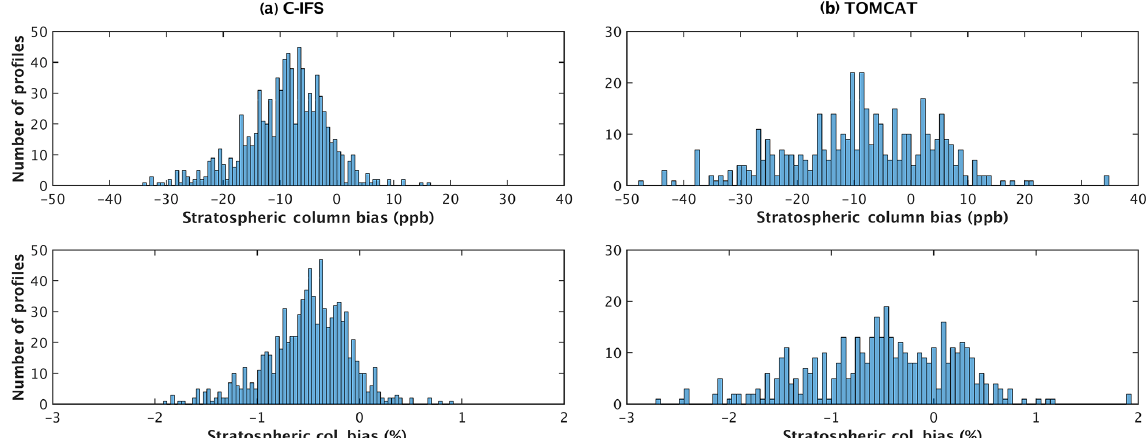
Figure 10. Histograms showing the distribution of the stratospheric column bias with respect to MIPAS at the MOZAIC airport locations for the year 2010 for (a) C-IFS model and (b) TOMCAT